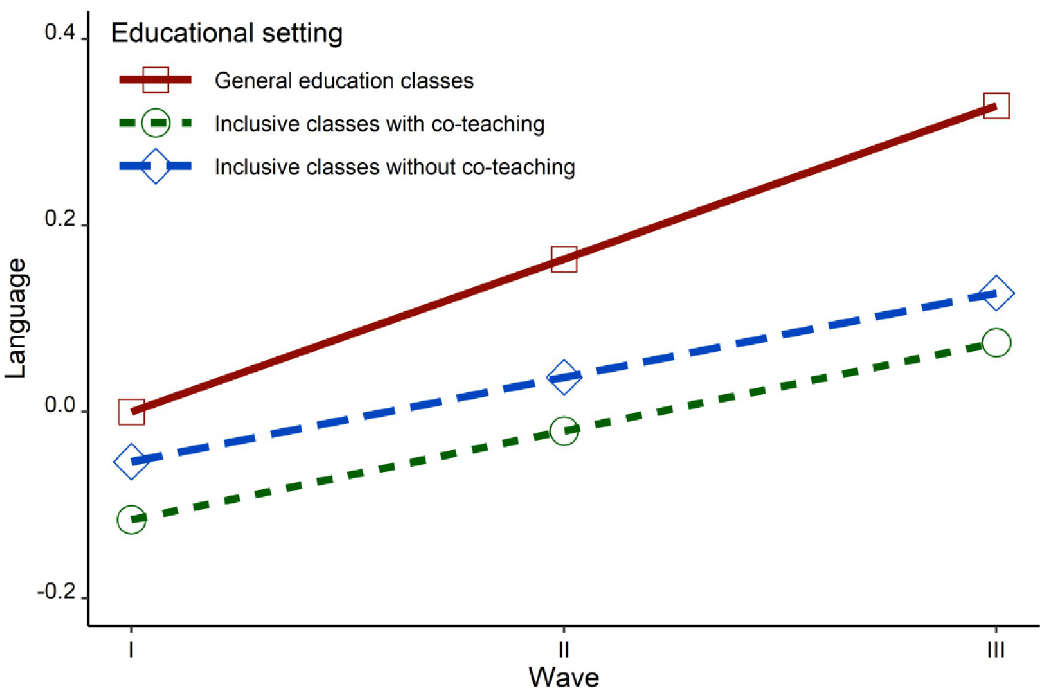
Fig 2. Changes in academic achievement in language across waves and educational